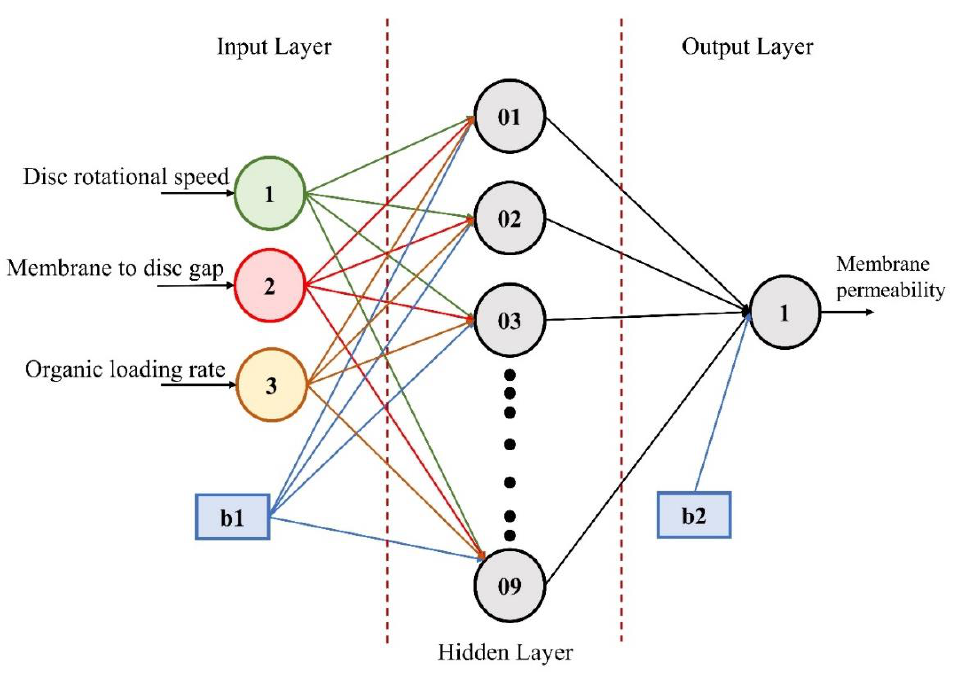
Figure 5. The architecture of the trained artificial neural networks model.